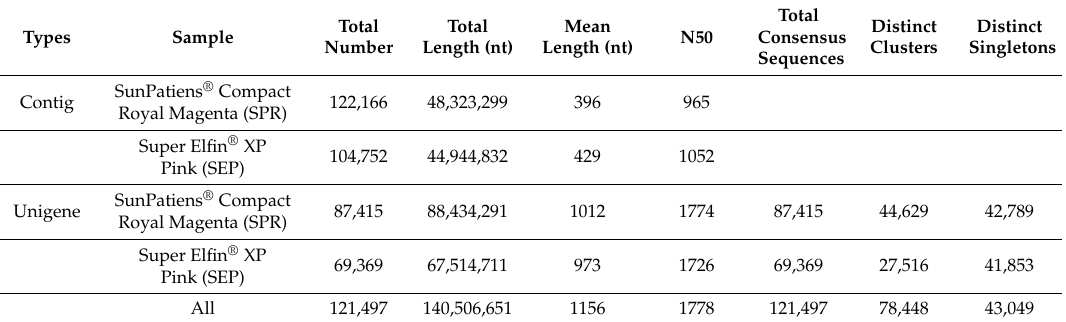
Table 2. Description of the impatiens transcriptome assembly and quality of unigenes and